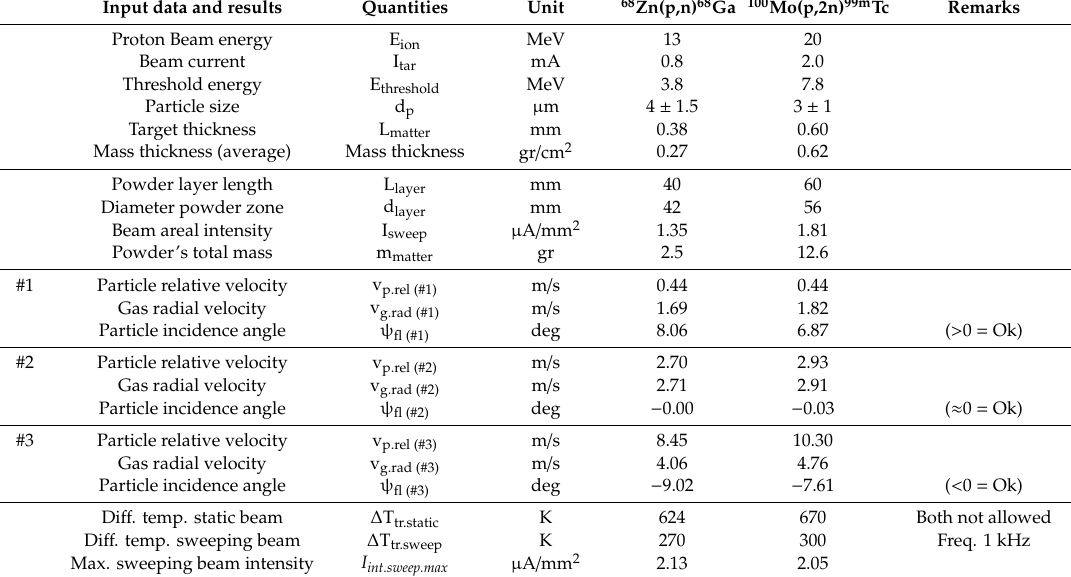
Table 1. Input data and results of 68 Zn and 100 Mo modeling and